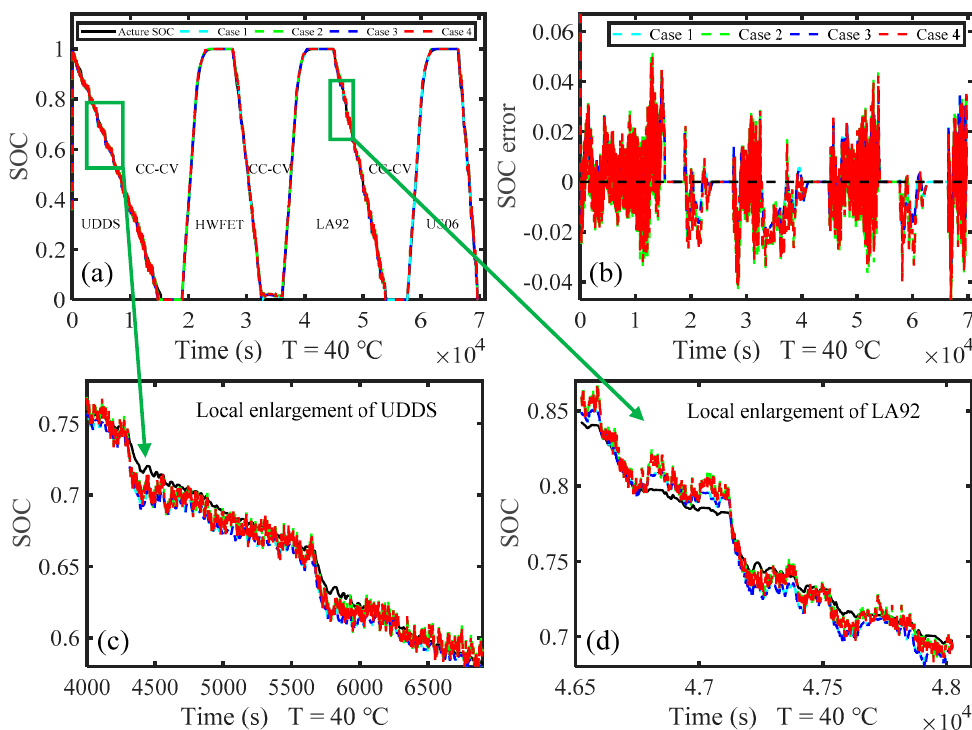
Figure 11. SOC and SOC error of GRU model in four cases at 40 °C: ( a ) SOC, ( b ) SOC error, ( c ) local enlargement of UDDS, ( d ) local enlargement of LA92.